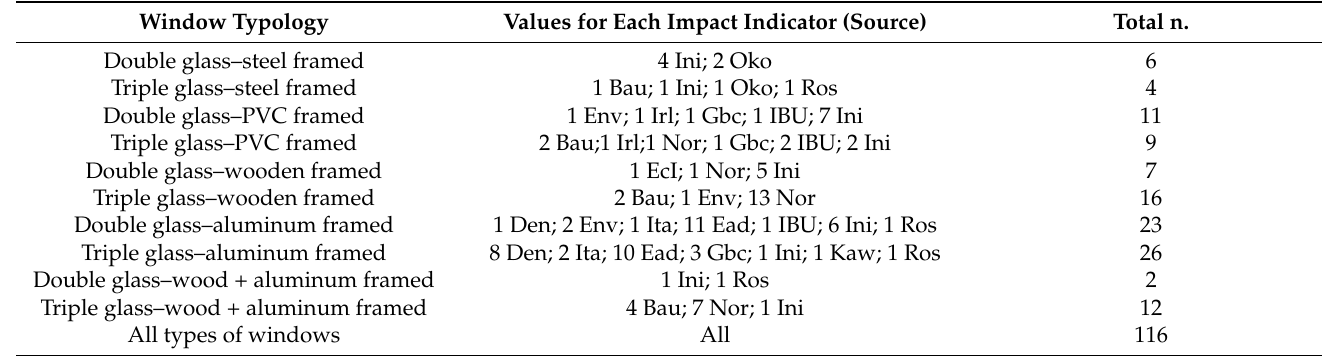
Table 3 lists the number of PENR, PER or GWP values obtained reporting, for every window typology, the reference database from which data were gathered. Table 3. Complete phases of the LCA analysis.